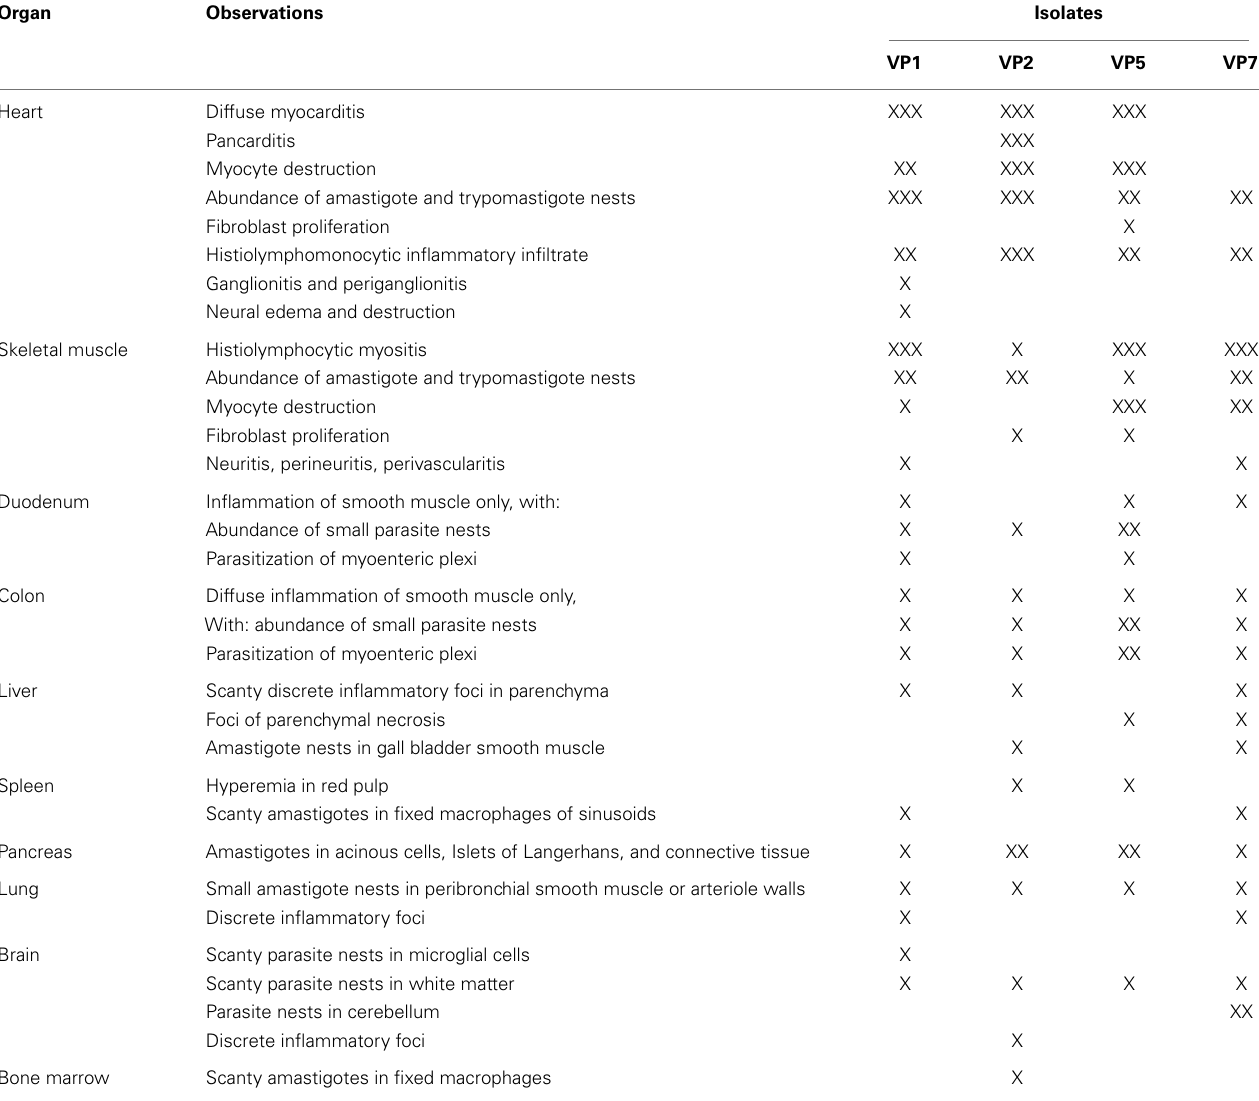
Table 1 | Histopathology in organs of white mice infected with isolates of Trypanosoma cruzi from urban Panstrongylus geniculatus .